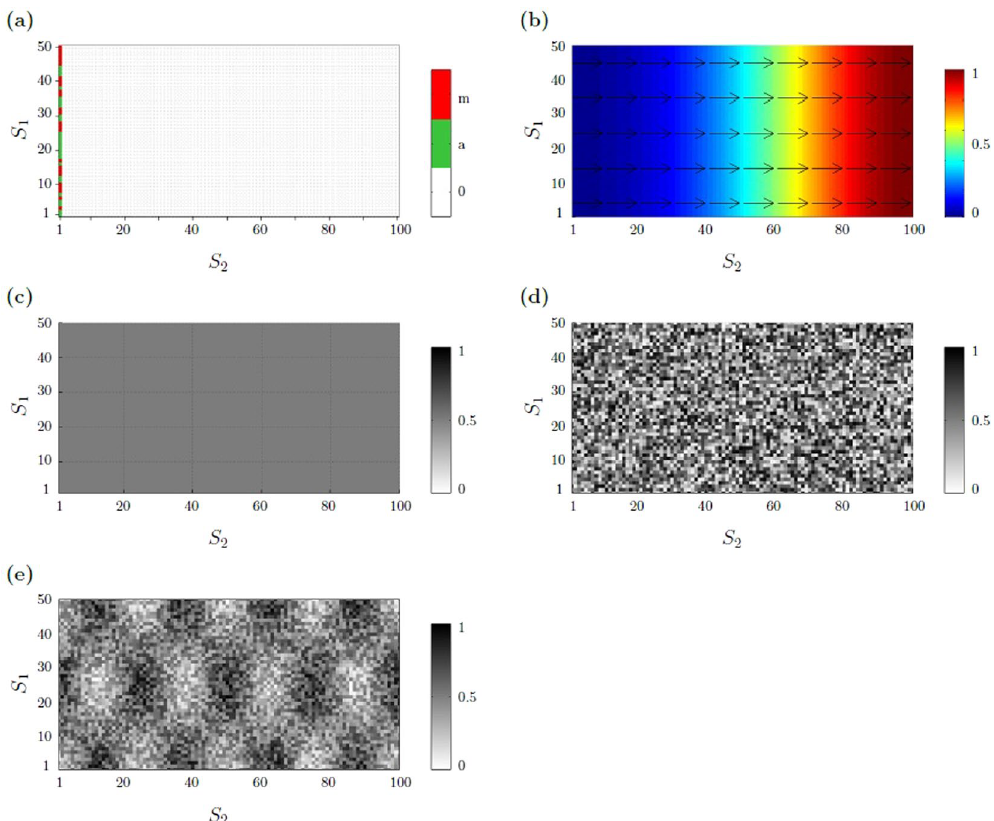
Figure 3. Initial model conditions. ( a ) Initial cell distribution. A - and M -cells are placed at random along the left border of a rectangular lattice. Periodic boundary conditions are applied along the S 1 axis. At S 2 = 1 reflecting boundary conditions are imposed. ( b ) Chemotactic gradient field defined by equation (1). The color code indicates the chemotactic gradient concentration function, where blue corresponds to low, red is related to high concentrations. The arrows illustrate the local gradient direction. ( c–e ) Initial ECM resistance distribution of differently structured ECM: ( c ) homogeneous, moderate ECM resistance distribution, modeled by a constant value μ ( r 1 , r 2 ) = 0.5; ( d ) heterogeneous, weakly structured ECM resistance distribution, defined by equation (2) with heterogeneity parameter θ = 0.1; ( e ) heterogeneous, highly structured ECM resistance distribution, defined by equation (2) with heterogeneity parameter θ = 0.5. The gray scale in ( c–e ) indicates the level of matrix resistance on cell migration: low (white) to high